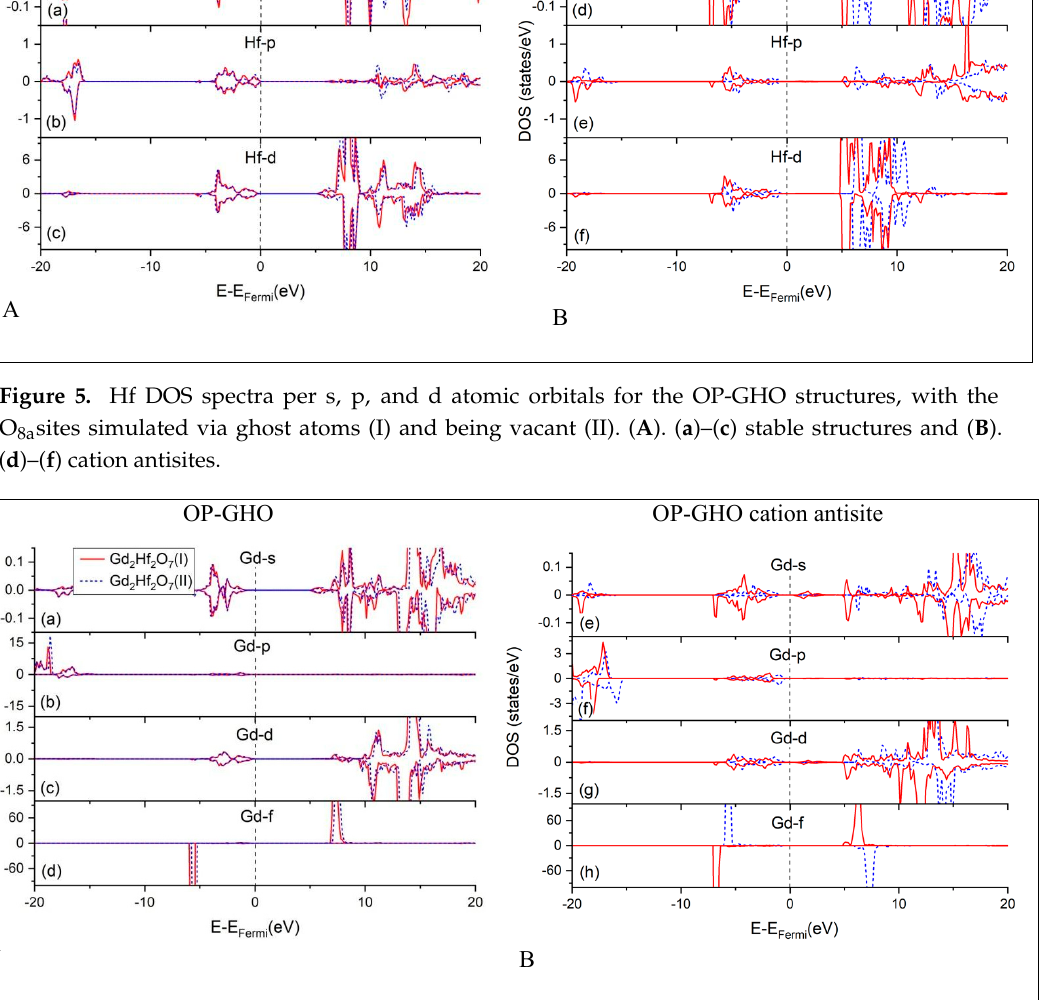
Figure 6. Gd DOS spectra per s, p, d, and f atomic orbitals for the OP-GHO structures, with the Ο 8a sites simulated via ghost atoms (I) and being vacant (II). ( A ). ( a ) – ( c ) stable structures and ( B ). ( d ) – ( f ) cation antisites.